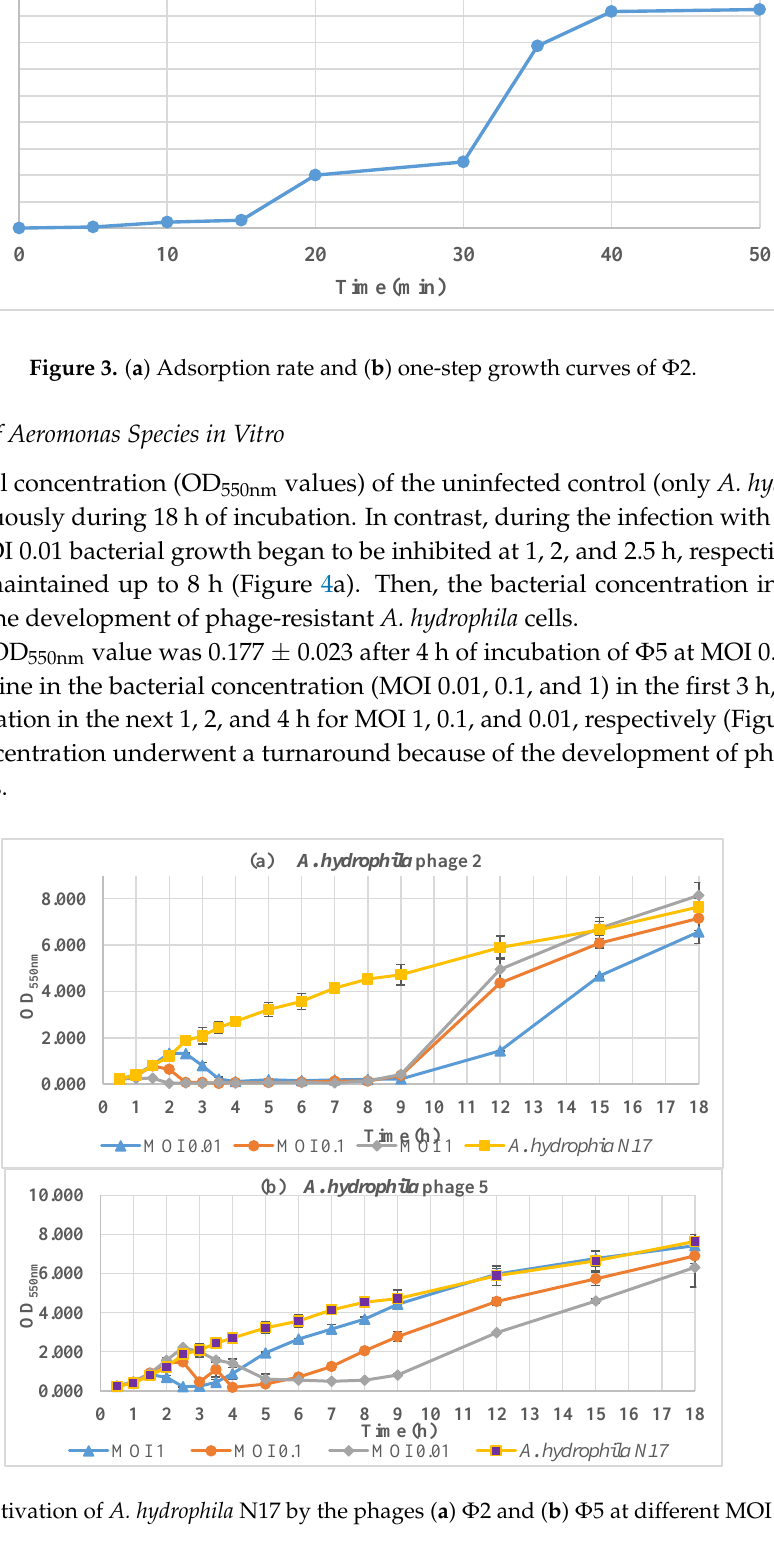
Figure 4. Inactivation of A. hydrophila N17 by the phages ( a ) 2 and ( b ) 5 at different MOI (0.01, 0.1 and 1).